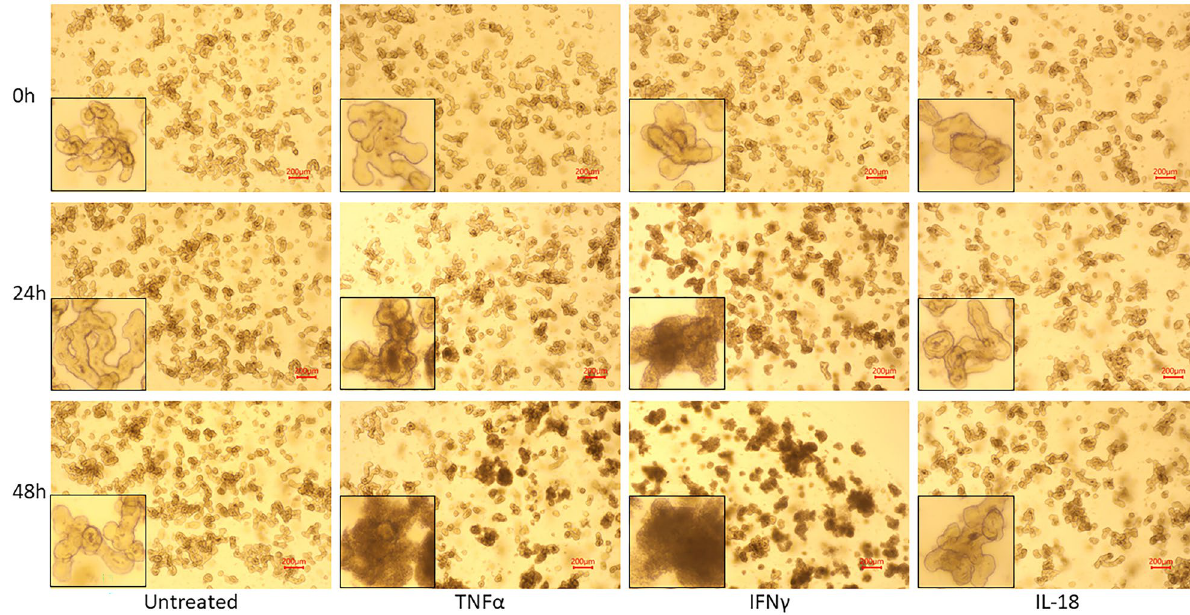
Figure 2. Morphological changes induced by cytokine treatment. Brightfield microscopy images of bovine intestinal organoids using a ×4 objective lens, treated with inflammatory cytokines for 24 and 48 h. Bottom left corners display a zoomed-in enteroid from each image. Scale bars denote 200